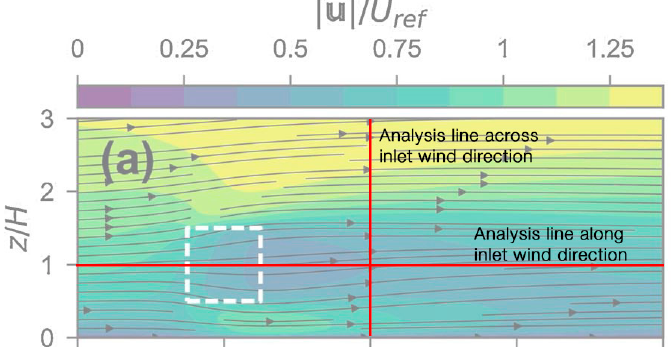
Figure A3. Region of analysis as performed by Manickathan et al. [29] and used for reference. Reproduced with permission from [29], Lento Manickathan, Thijs Defraeye, Jonas Allegrini, Dominique Derome, Jan Carmeliet, Agricultural and Forest Meteorology, Elsevier, 2018 (show in Supplementary Materials).